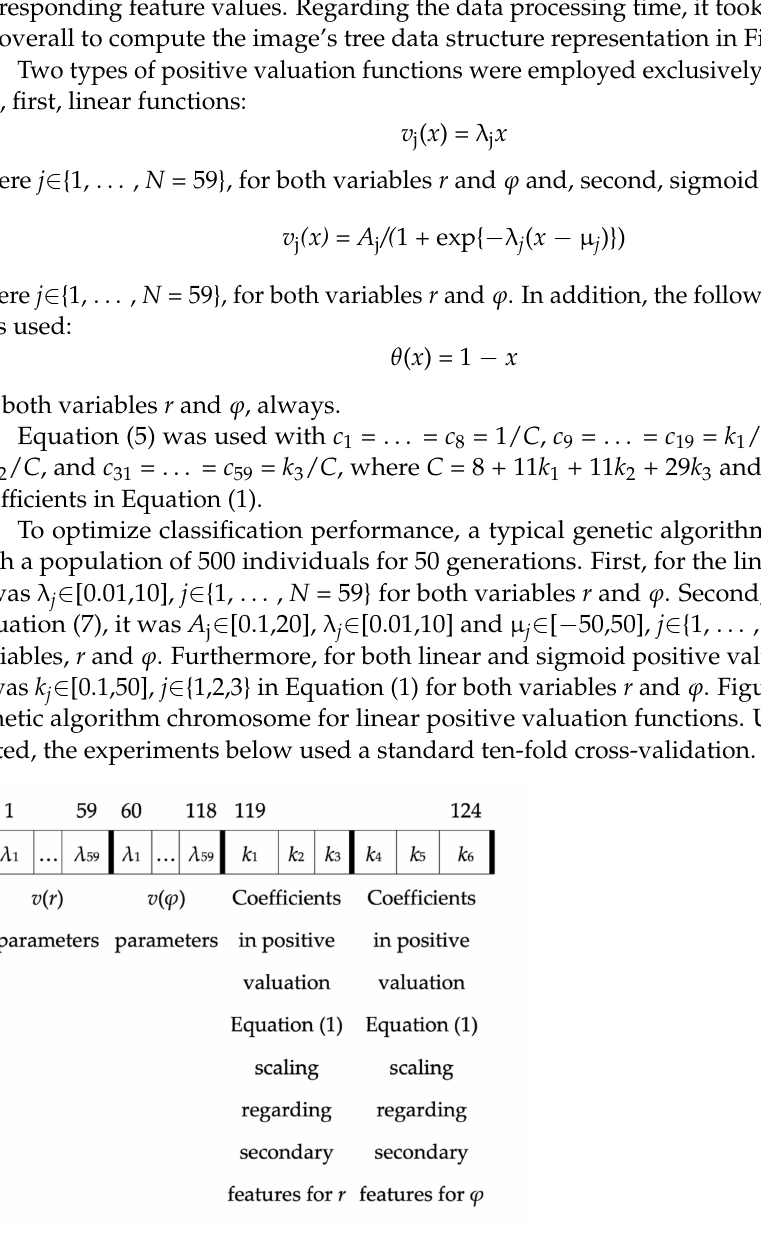
Figure 4. Chromosome of a genetic algorithm for linear positive valuation